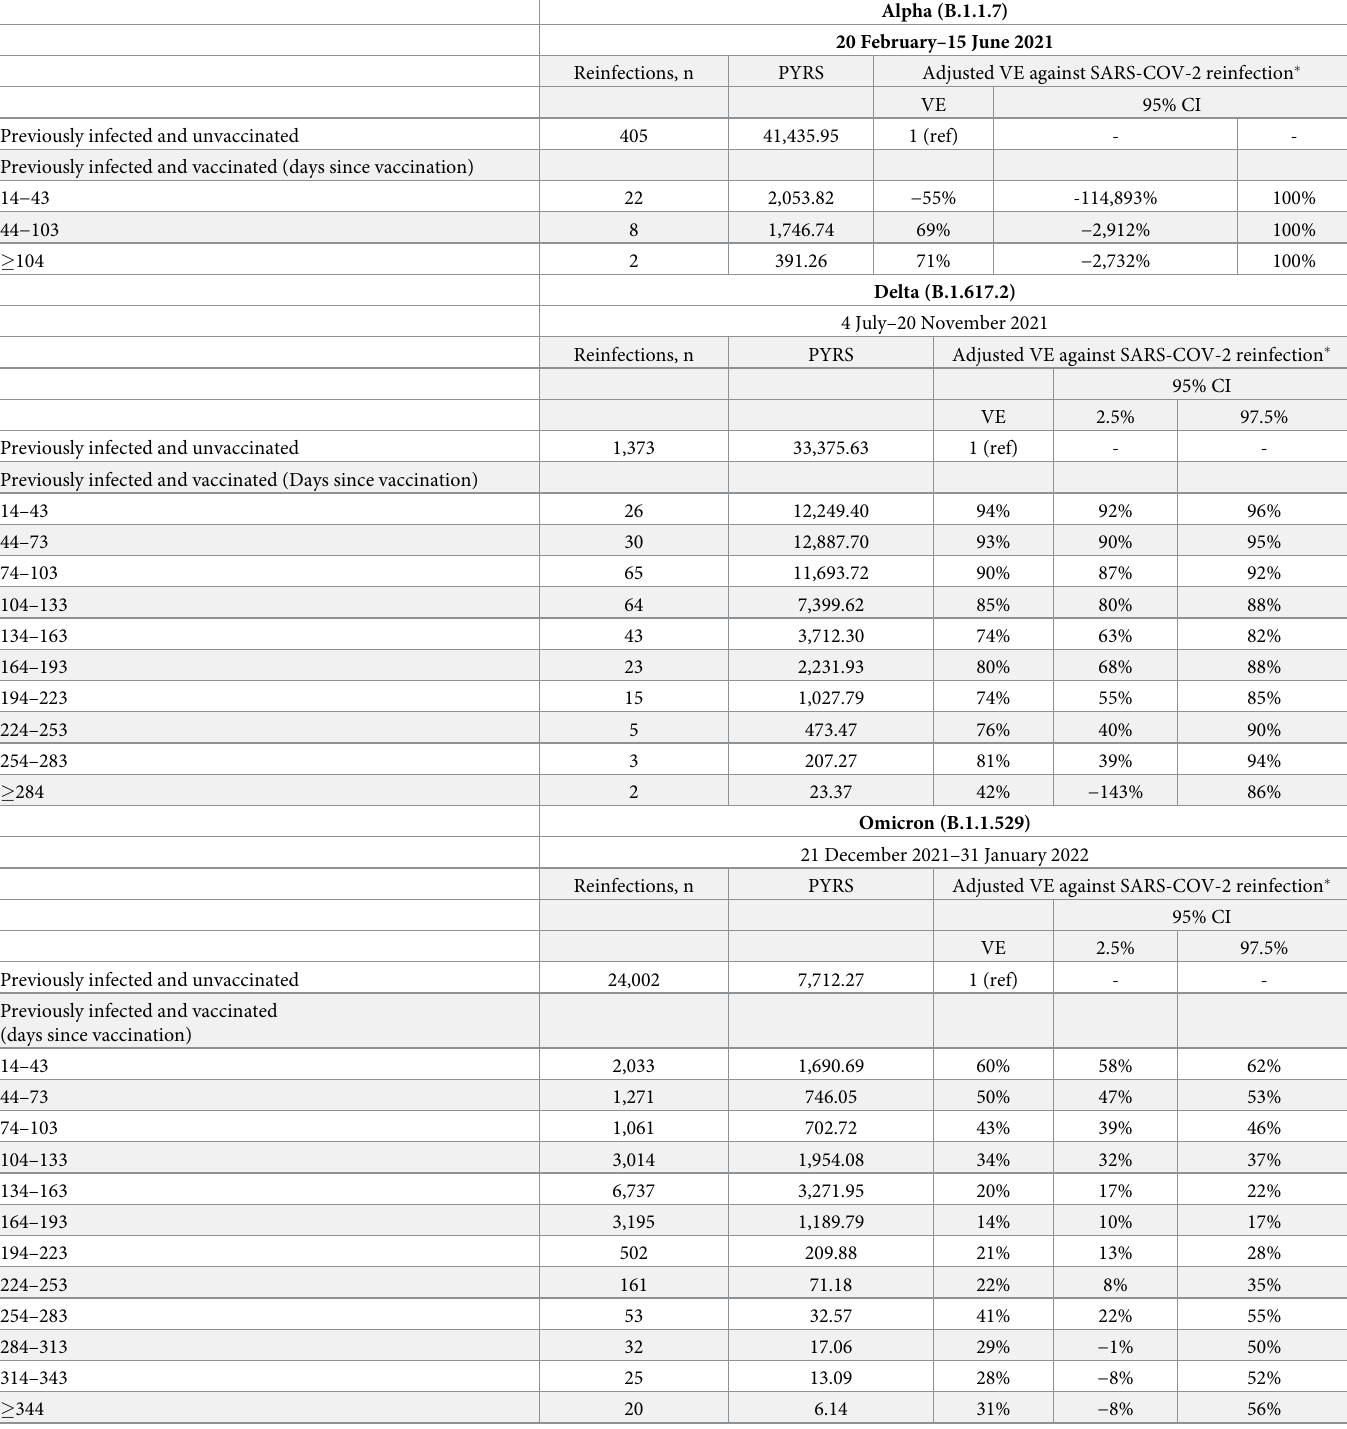
Table 2. Adjusted VE against SARS-CoV-2 reinfection during periods of Alpha, Delta, or Omicron